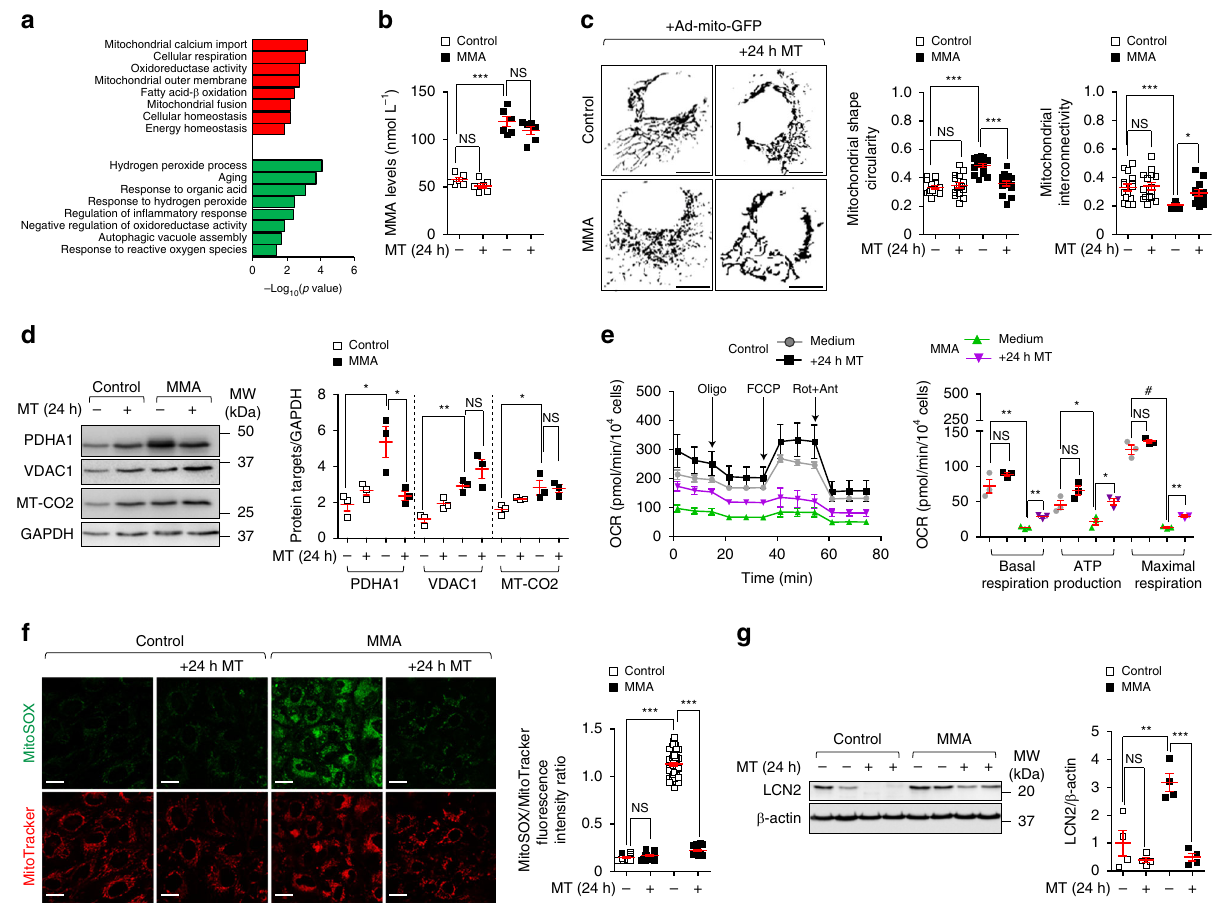
Fig. 8 Mitochondria-targeted ROS scavenger mito-TEMPO repairs mitochondrial functions in MMA kidney cells. a Gene ontology (GO) annotations signi fi cantly upregulated (red) and downregulated (green) by the in silico-prioritized hits according to Drug Set Enrichment Analysis (DSEA). b – g Cells were treated in the presence or in the absence of mito-TEMPO (MT; 10 μ M for 24 h). b Quanti fi cation of MMA levels by LC-MS/MS; n = 6 replicates. One-way ANOVA followed by Bonferroni ’ s post hoc test, *** P < 0.001 relative to untreated control or MMA cells. c Cells were transduced with adenovirus particles bearing the mitochondrially targeted GFP (Ad-mito-GFP, green). After 24 h post-transduction, the cells were treated with MT and analysed by confocal microscopy. Representative inverted images and quanti fi cation of mitochondrial circularity or interconnectivity. Circularity: n = 15 cells per each condition. Interconnectivity: n = 15 untreated and MT-treated control cells, n = 15 and n = 13 untreated and MT-treated MMA cells, respectively. One-way ANOVA followed by Bonferroni ’ s post hoc test, * P < 0.05 and *** P < 0.001 relative to untreated control or MMA cells. d Representative immunoblotting and quanti fi cation of the indicated mitochondrial proteins. GAPDH was used as a loading control. e Oxygen consumption rate (OCR) and individual parameters for basal respiration, ATP production and maximal respiration. OCRs were measured at baseline and after the sequential addition of Oligomycin (Oligo, 1 μ M), FCCP (0.5 μ M) and Rotenone (Rot, 1 μ M) + Antimycin A (Ant, 1 μ M). f Cells were loaded with MitoSOX (green, 2.5 μ M for 30 min at 37 °C) and MitoTracker (red; 1 μ M for 30 min at 37 °C), and analysed by confocal microscopy. Representative images and quanti fi cation of mitochondrial ROS (calculated as the ratio between MitoSOX and MitoTracker fl uorescence intensities; each point representing the average fl uorescence intensity ratio in a cell). Number of untreated ( n = 36) or MT-treated ( n = 28) control cells and number of untreated ( n = 51) or MT-treated ( n = 28) MMA cells.